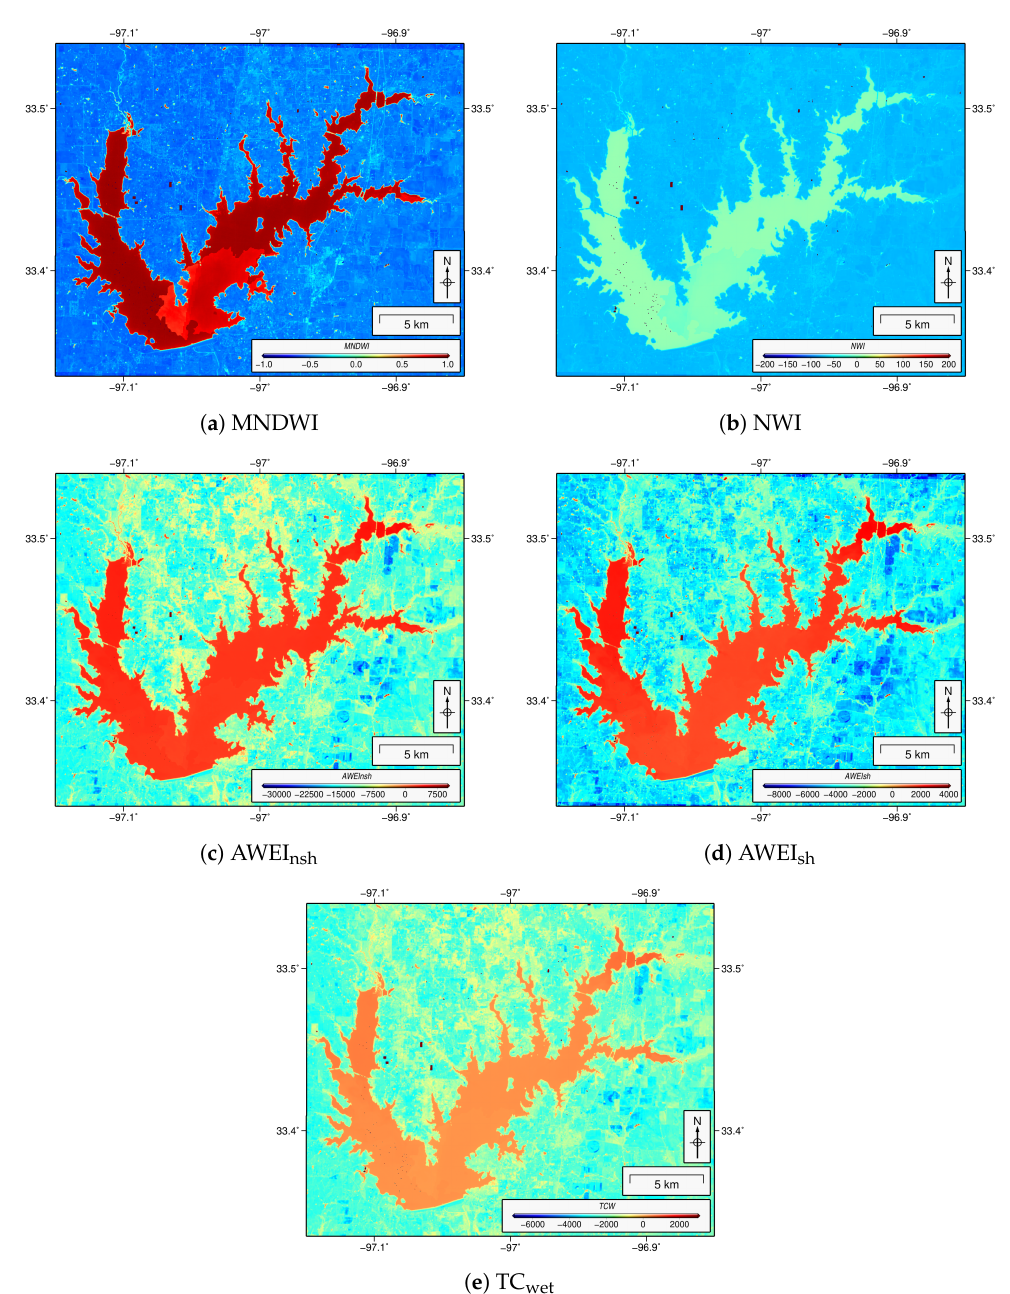
Figure 6. The used water indexes, Modified Normalized Difference Water Index (MNDWI), New Water Index (NWI), Automated Water Extraction Index for Non-Shadow Areas (AWEI nsh ), Automated Water Extraction Index for Shadow Areas (AWEI sh ) and Tasseled Cap for Wetness (TC wet ) are shown for Lake Ray Roberts in January